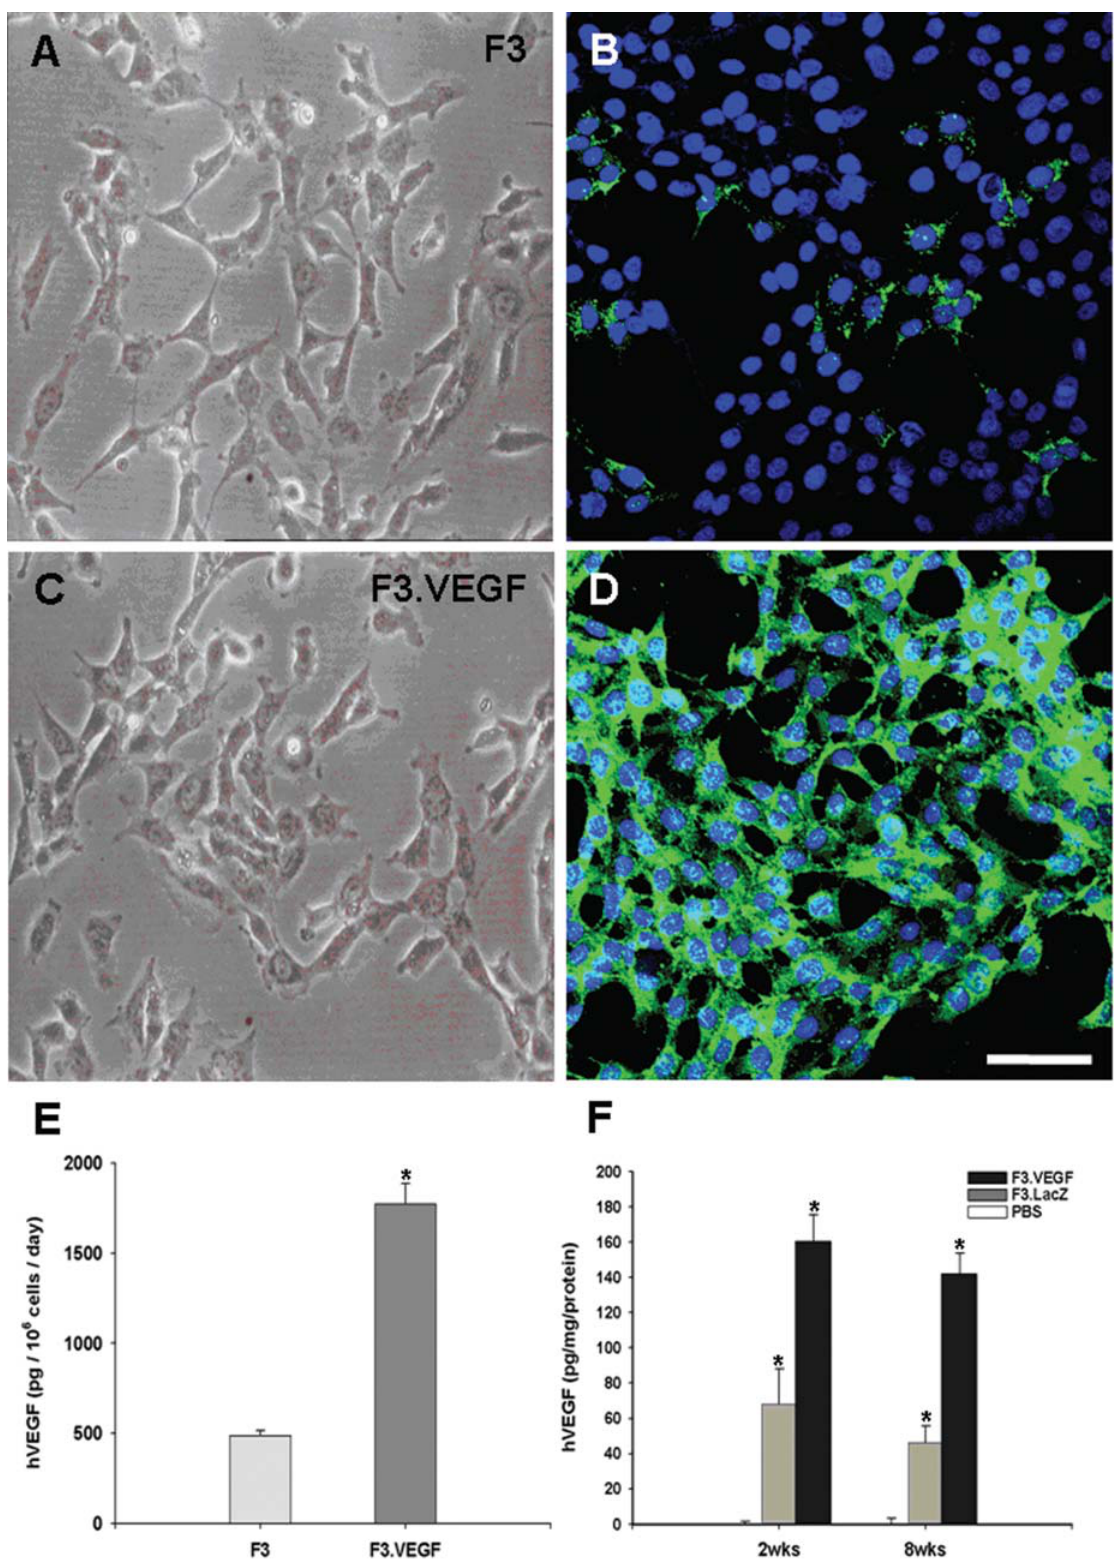
Figure 2. Immunofluorescence microscopy demonstrating production of VEGF in parental F3 human neural stem cell line (A, C) and F3.VEGF, the human neural stem cell line overexpressing VEGF (B, D). Results from the ELISA assay for human VEGF indicate that the levels of VEGF in spent media from F3.VEGF cell line are 5 times over those of F3 cell line (E). Levels of VEGF production in brain sections isolated from intracerebral hemorrhage (ICH) mice grafted with F3 or F3.VEGF human neural stem cells (F). VEGF levels are significantly higher in the F3.VEGF-transplanted mice 2 weeks and 8 weeks post-transplantation as compared with ICH mice grafted with F3 cell line. *: P , 0.001, **: P , 0.05 doi:10.1371/journal.pone.0000156.g002 PLoS ONE |